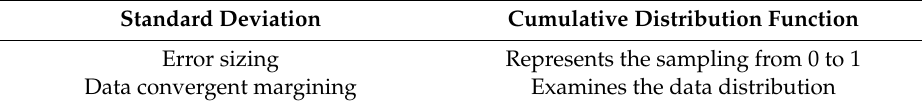
Table 2. Standard deviation and cumulative distribution function comparison.